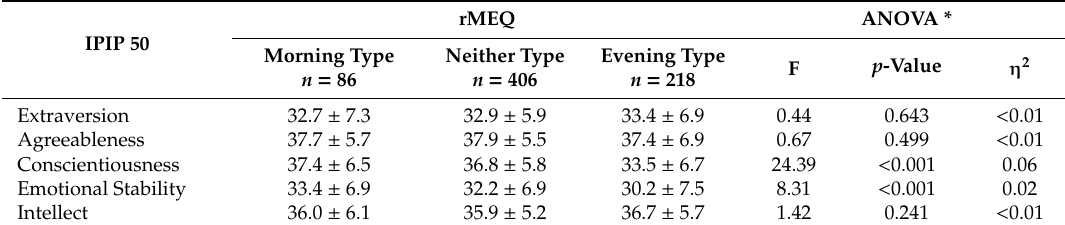
Table 6. Descriptive statistics (mean ± SD) of the IPIP 50 Big-Five questionnaire domains according to the reduced morningness-eveningness questionnaire (rMEQ).